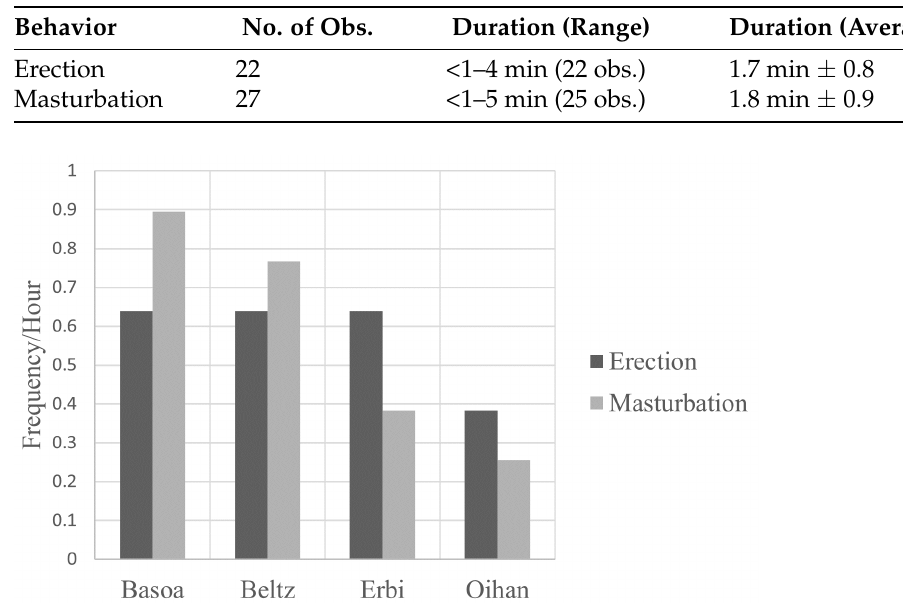
Table 4. Duration of E/M in Pottoka ponies